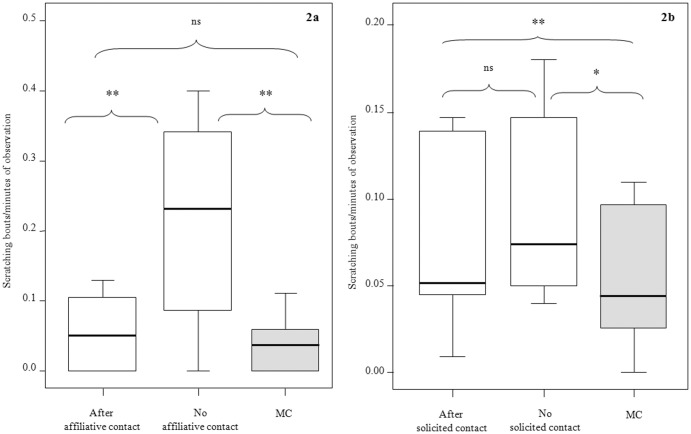
Anxiety related scratching and third party affiliation.Box plots of scratching frequency: 2a) after spontaneous affiliative contact, in absence of affiliative contact and under control conditions (MC); 2b) after solicited affiliative contact, in absence of affiliative contact and under control conditions (MC). Solid horizontal lines indicate medians; box length corresponds to the interquartile range; thin horizontal lines indicate the observed value range. Double and single asterisk, and “ns” indicate highly significant (p<0.01, **), significant (p<0.05, *) and non-significant results respectively. Results were obtained via Dunnett's post-hoc test.